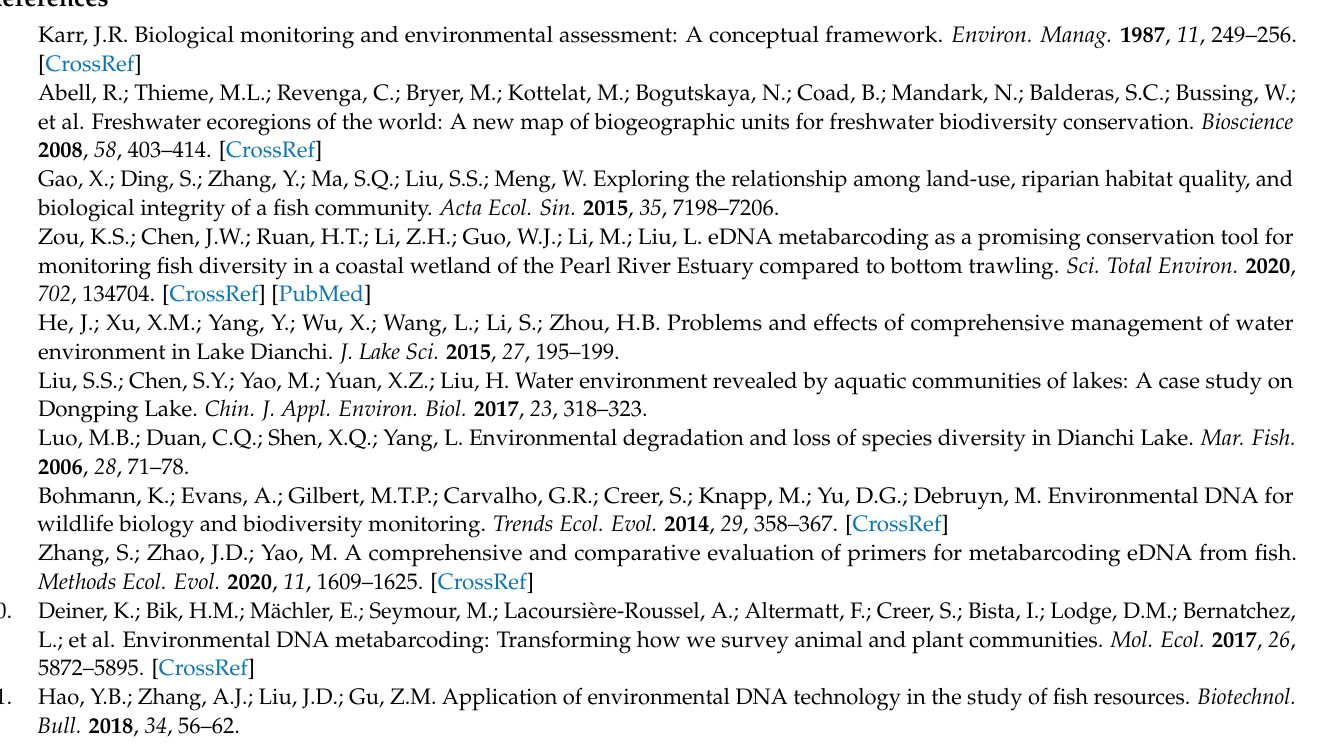
inflowing rivers. Table S3: Correlation coefficients of Pearson tests between nine candidate metrics. Table S4: Classification of F-IBI in Dianchi lake and the three inflowing